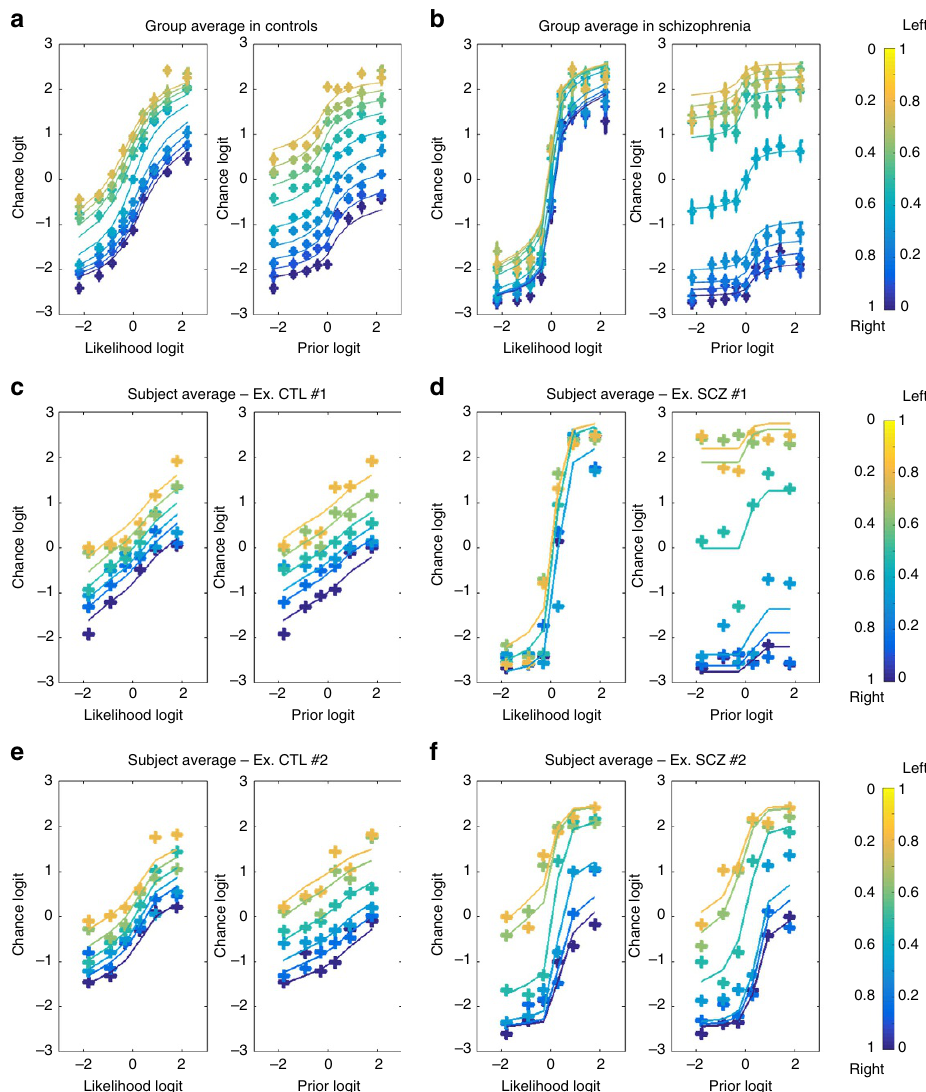
Figure 3 | Participant confidence and predictions based on the circular inference model. The mean chance logit is plotted as a function of the likelihood logit or the prior logit. The likelihood and prior information is colour-coded (from dark blue to yellow) according to the true probability that the fish originated from one of the two lakes in the Fisher task. For each plot, the data fits obtained using the circular inference model are overlaid as solid lines using the same colour code. ( a ) Chance logit plotted against the likelihood (left) and prior (right) among healthy CTLs; ( b ) Chance logit plotted against the likelihood (left) and prior (right) among the patients with SCZ. ( c , e ) Data from two CTL participants. Note that one participant ( e ) exhibited a tendency to jump to conclusions (sigmoidal), whereas the other ( c ) made Bayesian decisions (linear) in the Fisher task. ( d , f ) Data from two participants in the SCZ group. Participant ( d ) exhibited an extreme jumping-to-conclusions pattern compared with participant ( f ); once again, however, the circular inference model provided the best fit for these data despite their heterogeneity. (Data and model fits for each participant are provided in Supplementary Figs 3 and